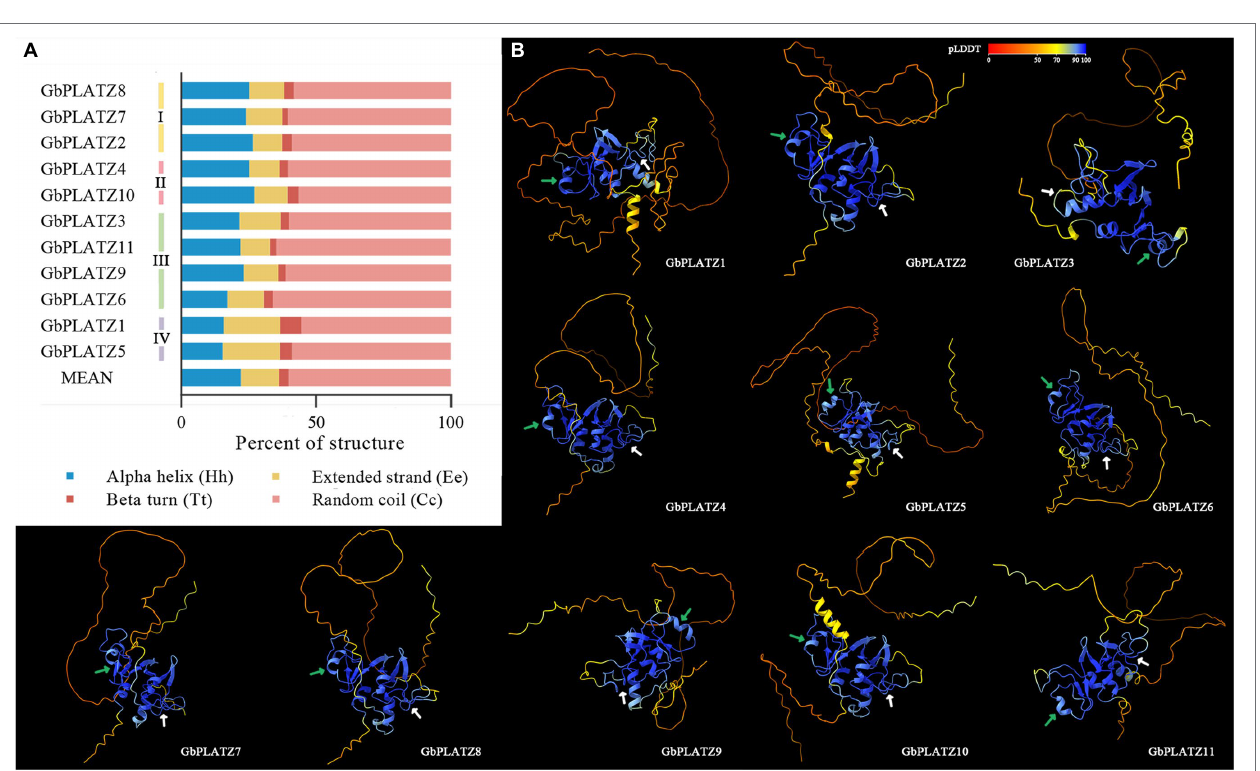
FIGURE 5 | Protein secondary and tertiary structure prediction of GbPLATZs. (A) Prediction of protein secondary structure based on SOPMA. (B) Protein tertiary structure prediction based on AlphaFold2, protein coloring represents the pLDDT confidence measure, and green and white arrows represent the approximate location of domain 1 and domain 2, respectively.